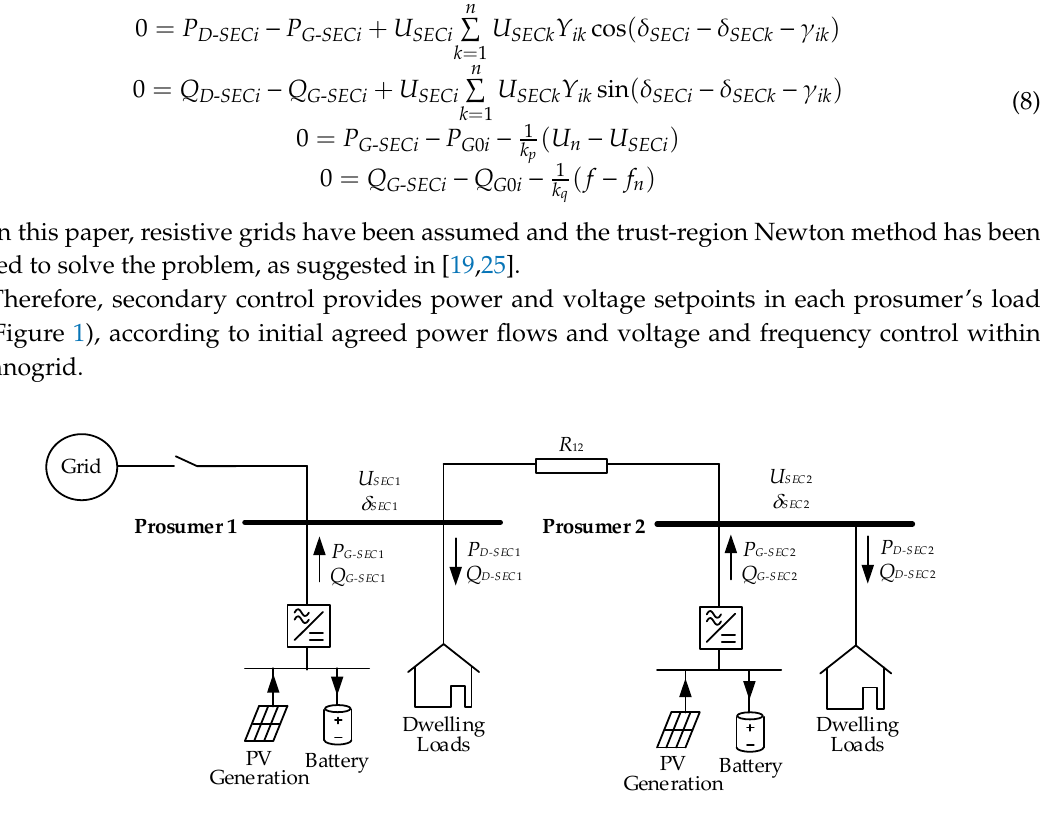
Figure 1. Secondary control setpoints in the nanogrid.